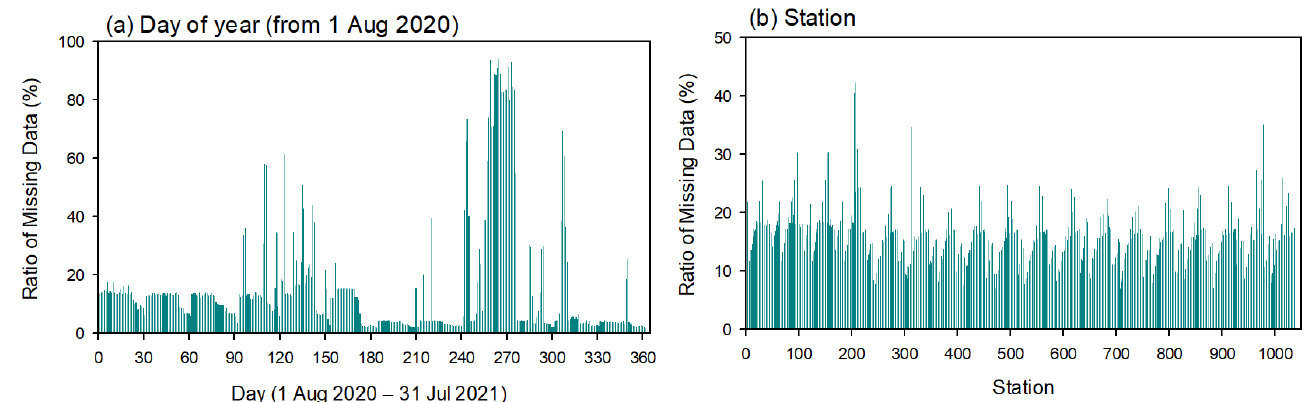
Figure 10. Ratio of missing data with respect to ( a ) day of the year and ( b ) station alphabetical order.